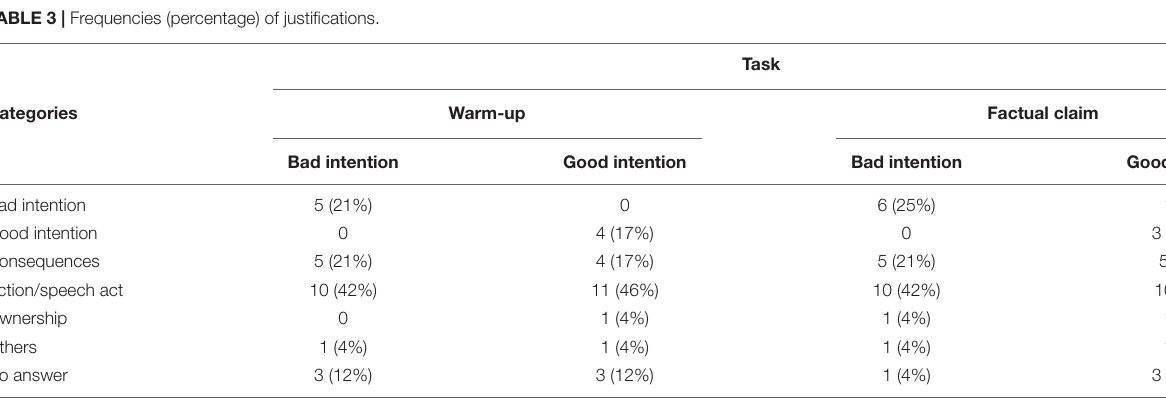
TABLE 4 | Association evaluation and